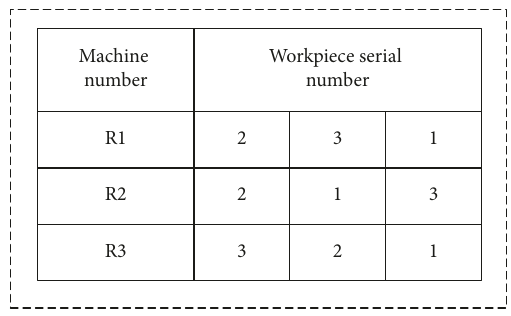
Figure 6: Dynamic data scheduling scheme of the 3 × 3 flexible industrial job shop. Table 1: Experimental parameters.